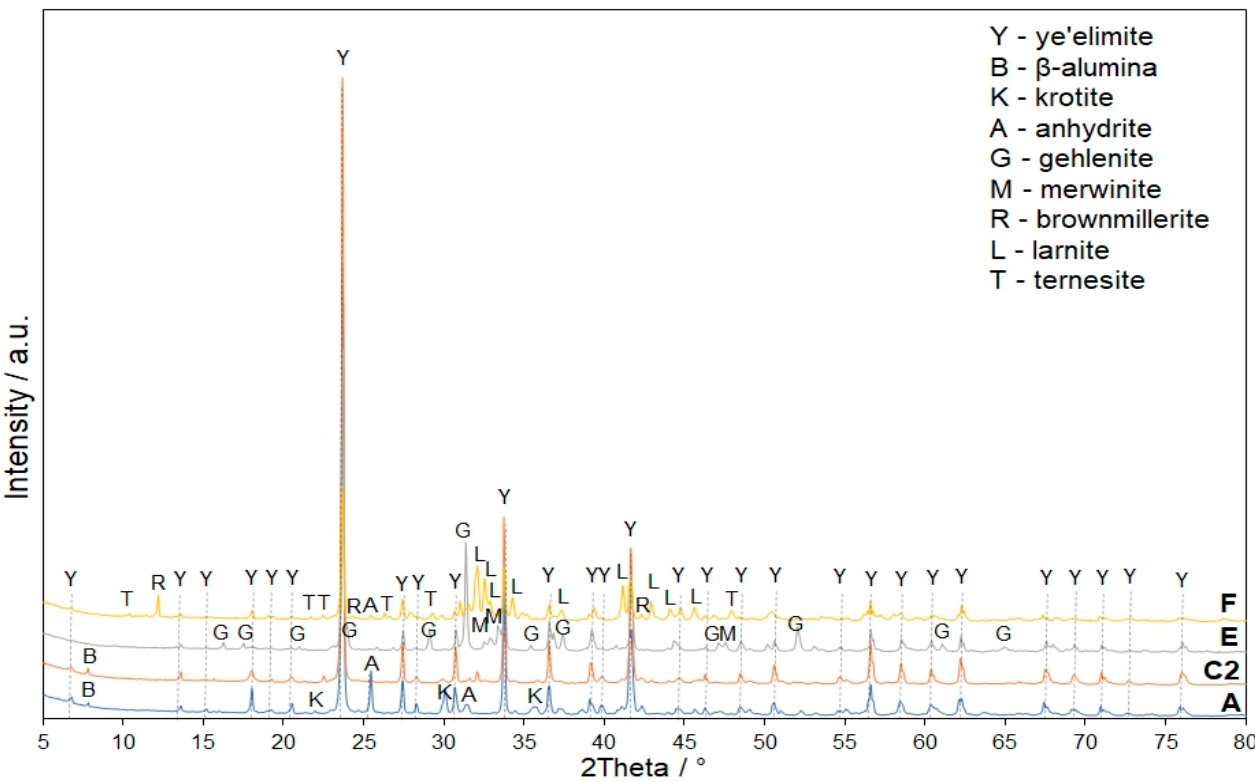
Figure 8. XRD patterns of the obtained materials after synthesis at 1350 °C/8 h.